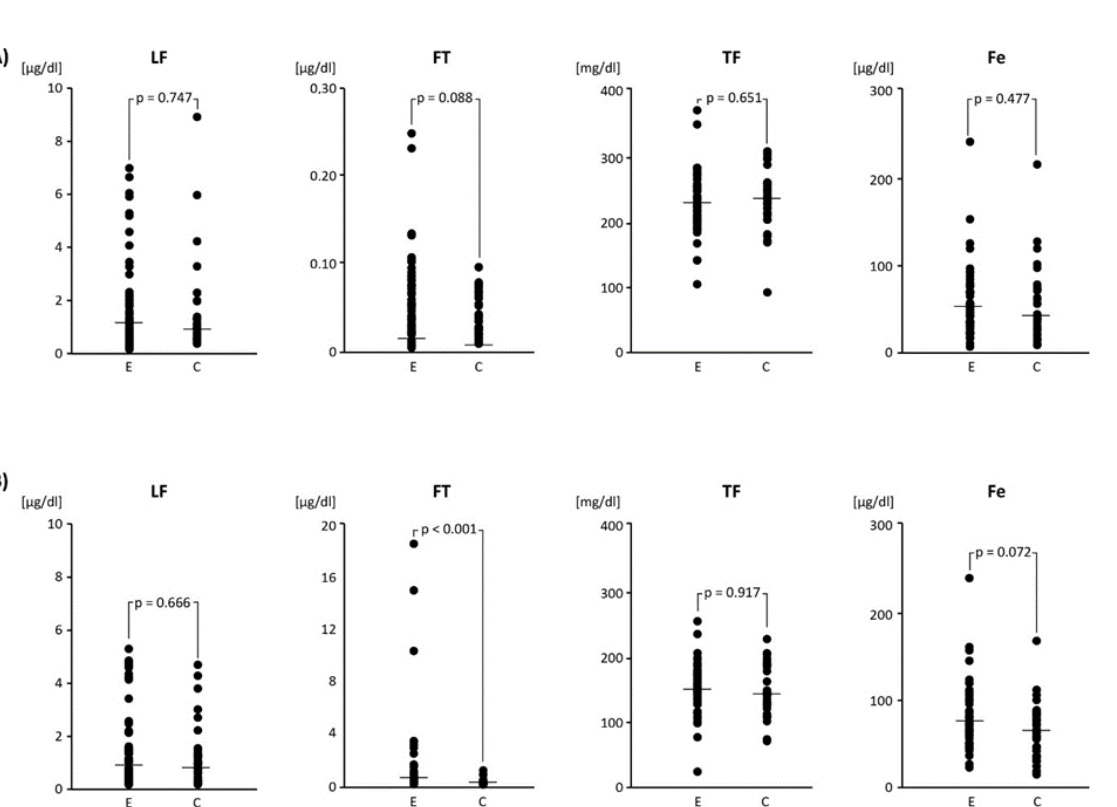
Figure 1. Comparison of concentrations of tested variables:; lactoferrin (LF), ferritin (FT), transferrin (TF) and iron (Fe) between the group of with (E, n = 57) and without (C, n = 33) endometriosis, respec- tively, for plasma ( A ) and peritoneal fluid ( B ). p -values from U -MannWhitney test for independent observations between group with endometriosis (E) and without endometriosis (C) for plasma ( A ) and peritoneal fluid ( B ). The dots represent a single score, the dash represents the